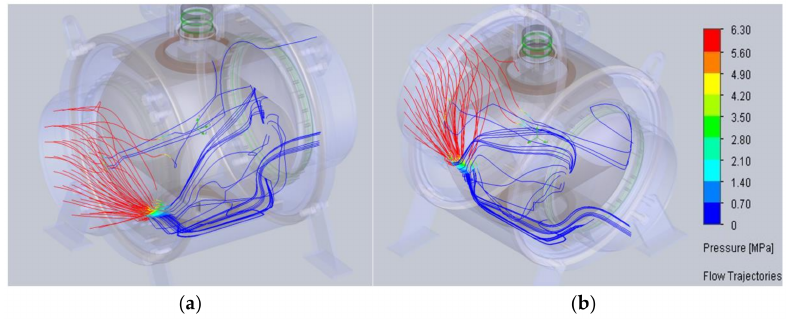
Figure 14. Fluid flow trajectories for the fully closed valve: ( a ) upstream view; ( b ) downstream view.